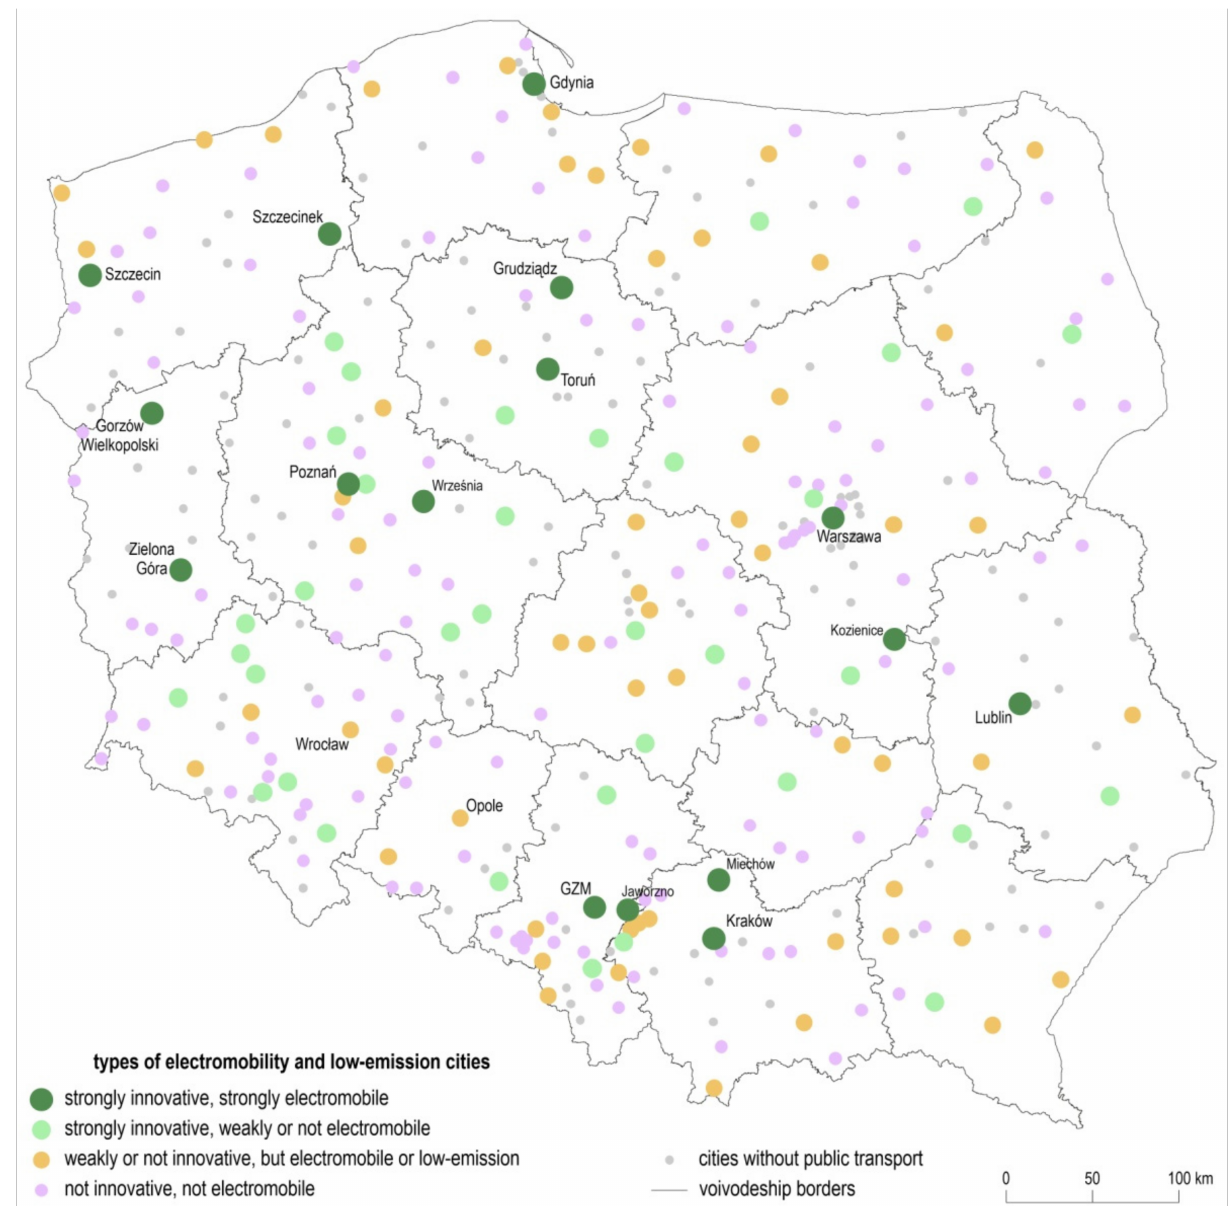
Figure 6. Cities and towns in Poland by types of electromobility and low-emission. Source: own elaboration of the